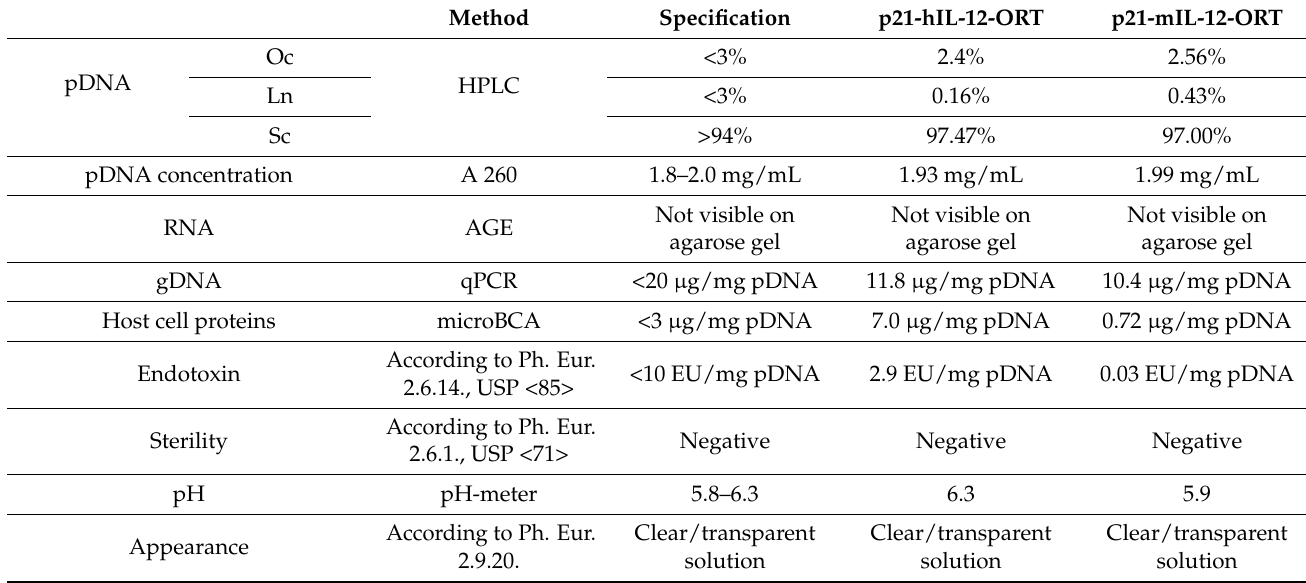
Figure 4. HPLC analytics of bulk products. Conditions: CIMac™ pDNA-0.3 analytical column; flow rate of 1 mL/min; mobile phase ( a ): 200 mM Tris, pH 8.0; mobile phase ( b ): 200 mM Tris, 1.0 M NaCl, pH 8.0; UV detection—260 nm. Table 2. Specification of plasmid DNA used for in vitro